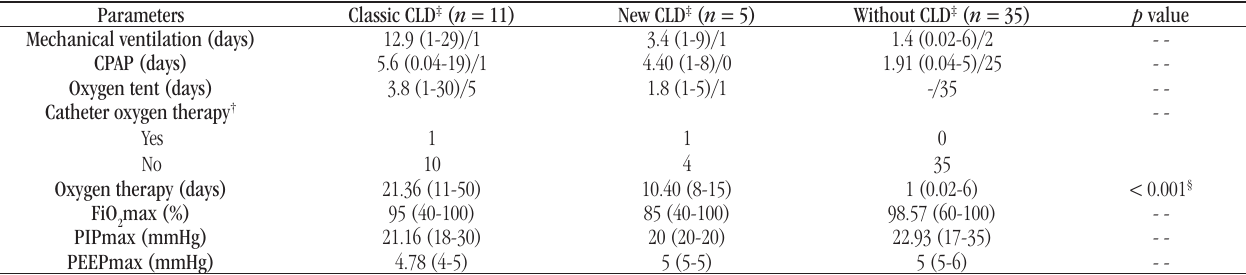
taBLE 4 − The parameters of oxygen therapy for the three